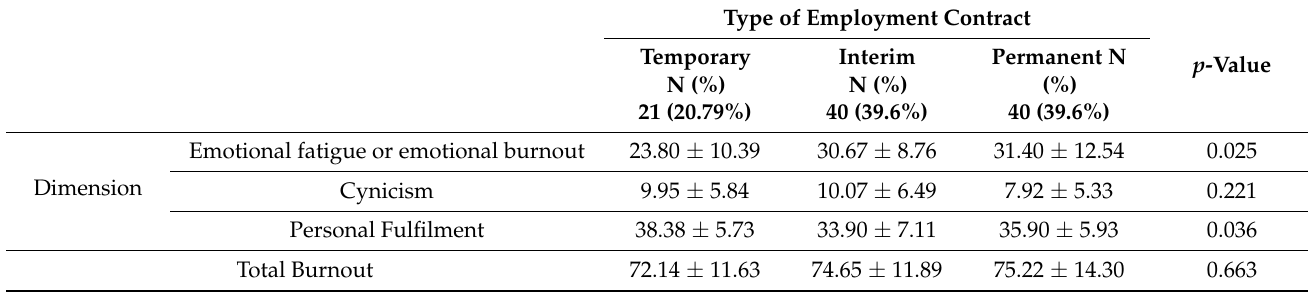
Table 2. Average score of burnout and dimensions as per type of employment